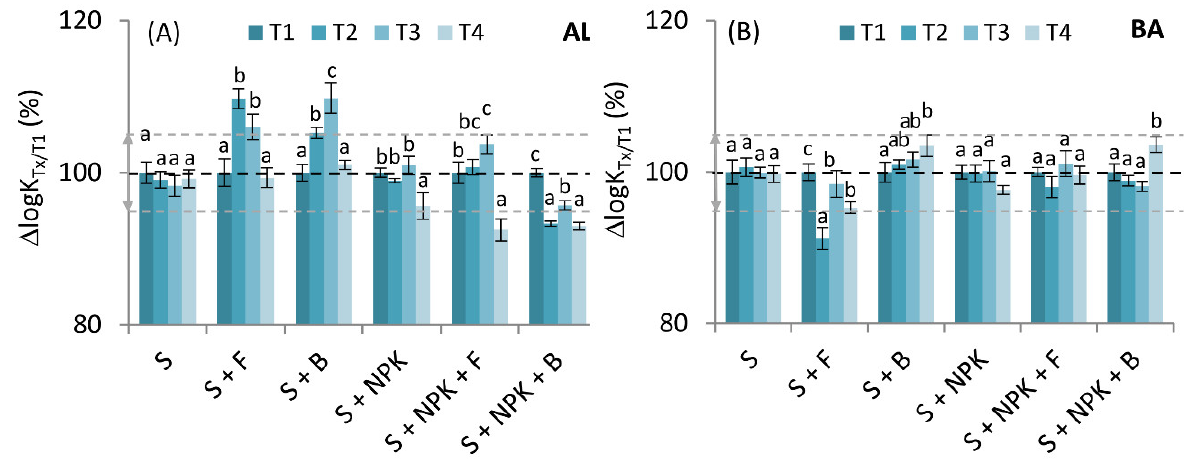
Figure 6. Changes in the Kumada degree of humification ( ∆ lgK) in the form of relative values with ± 5% thresholds marked in gray lines; ( A )—humic acids (HAs) from Abruptic Luvisol (AL) soil, ( B )—humic acids (HAs) from Brunic Arenosol (BA) soil. The values measured at T2, T3, and T4 were compared to the control (100%) marked as T1. S—soil without additives, S + F—soil with fungal strains, S + B—soil with bacterial strains, S + NPK—soil with NPK, S + NPK + F—soil with fungal strains and NPK, S + NPK + B—soil with bacterial strains and NPK. The figure shows mean values ± standard deviation. The same, small letters mean no significant differences between the values at the level of significance α = 0.05 (one-way ANOVA variance analysis, Tukey’s HSD test).